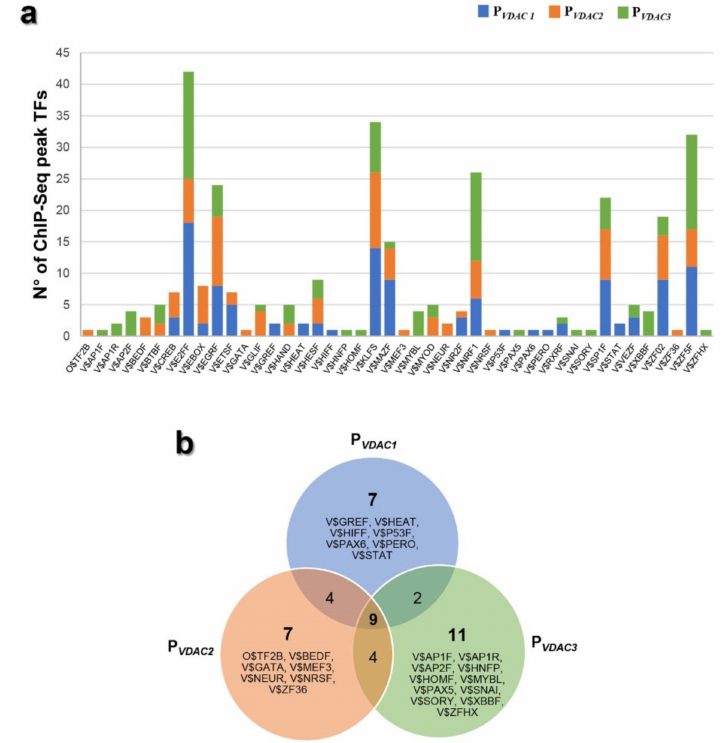
Figure 6. Identification of ChIP-seq peak regions in the human VDAC promoters. ( a ) The histogram shows the number of transcription factor binding sites (TFBS) experimentally validated by ChIP-Seq data (ENCODE project v3) among those predicted by the software Genomatix (MatInspector) in P VDAC1 , P VDAC2 , and P VDAC3 sequences. ( b ) Venn diagram showing the number of common and unique predicted binding sites that overlap with a ChIP-Seq region in P VDAC1 , P VDAC2 , and P VDAC3 , based on Genomatix